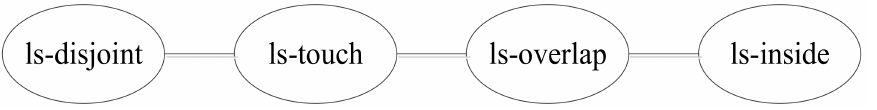
Figure 12. Conceptual neighborhood diagram of topological relations between a line segment and a